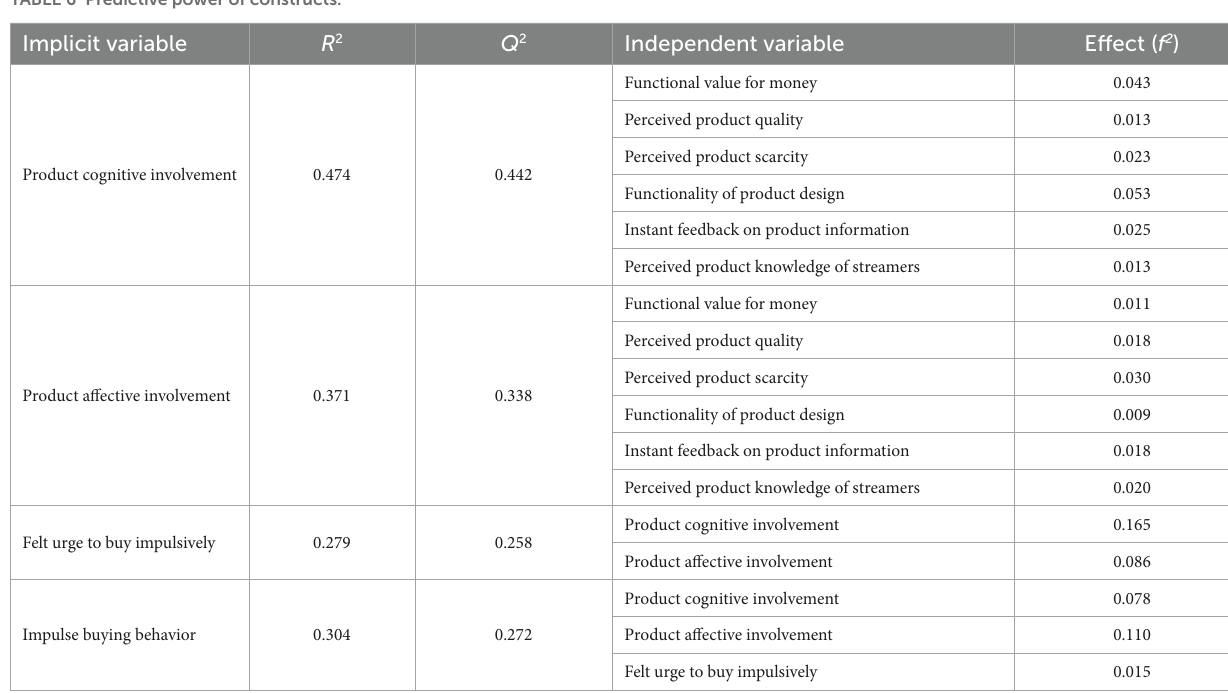
TABLE 6 Predictive power of